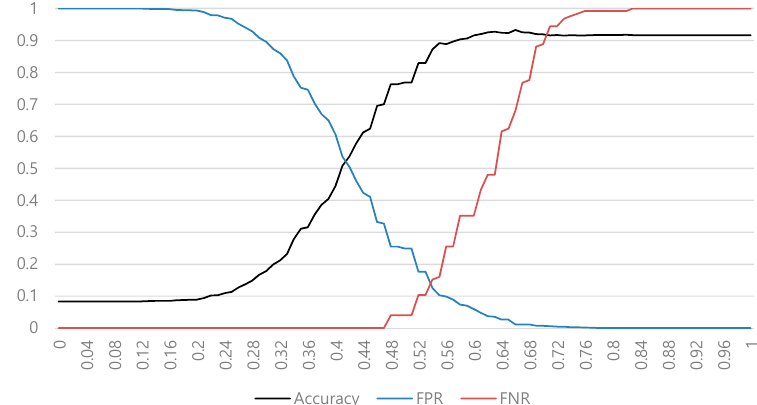
Figure 3. Structure similarity of data compared with obfuscation type 1 with a conventional AST.